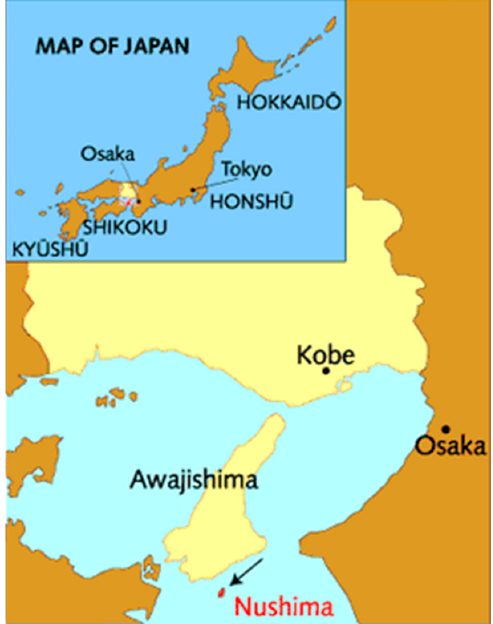
Figure 1. The location of Nushima Island. Source: Web-Japan.org [1].